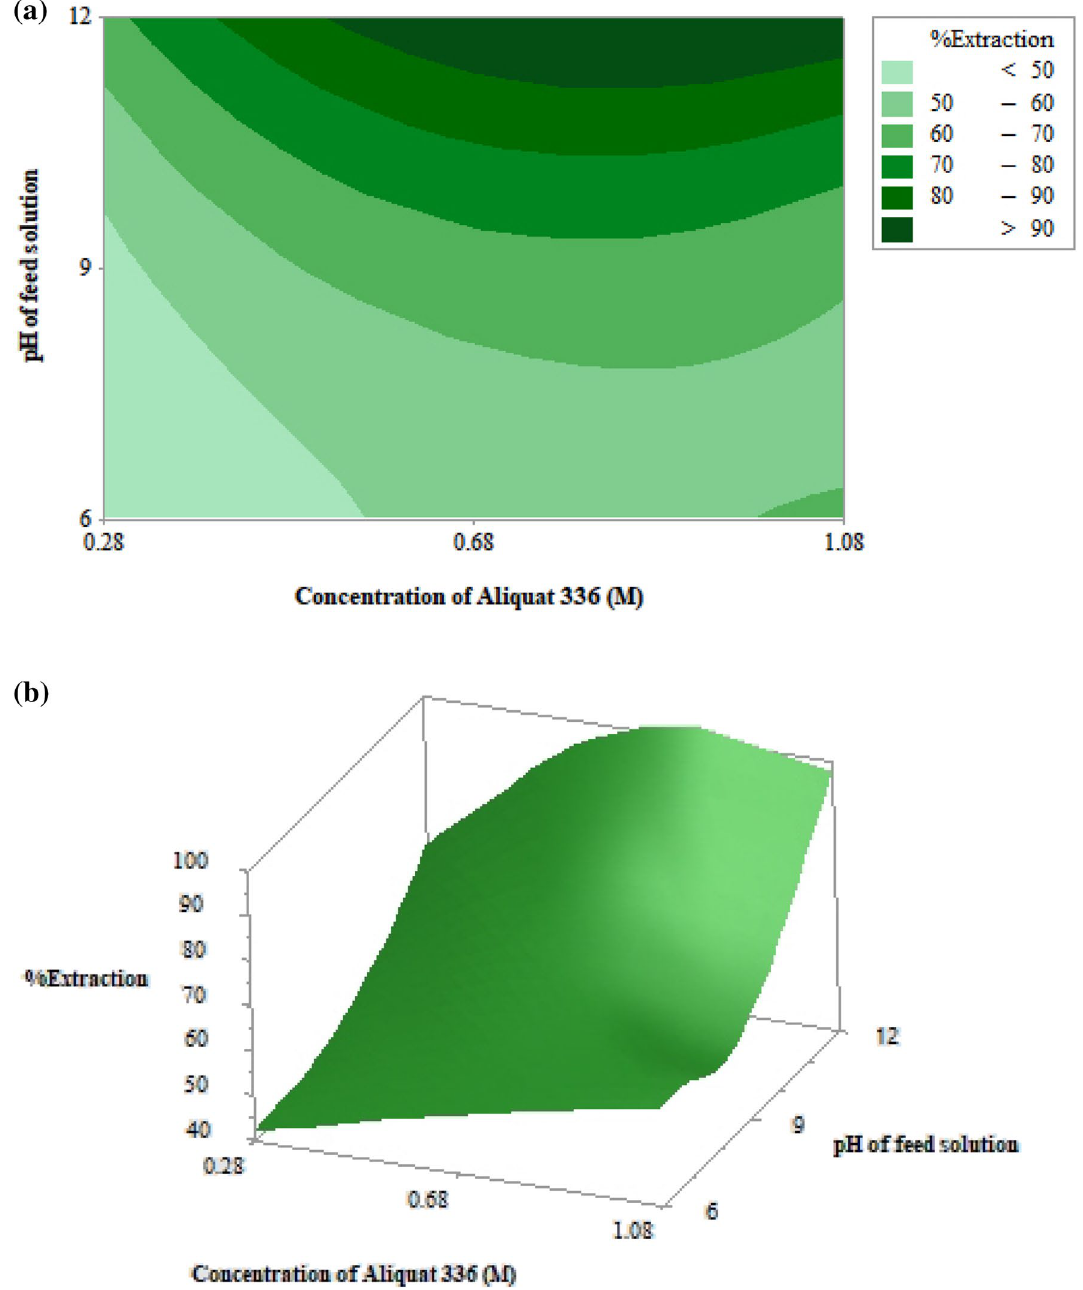
Figure 5. Percentages of extraction of arsenic ions against concentration of Aliquat 336 and pH of feed solution via HFSLM using 0.5 M NaOH as the strippant solution, at flow rates of feed and strippant solutions of 100 mL/ min: ( a ) contour plot. ( b ) Surface